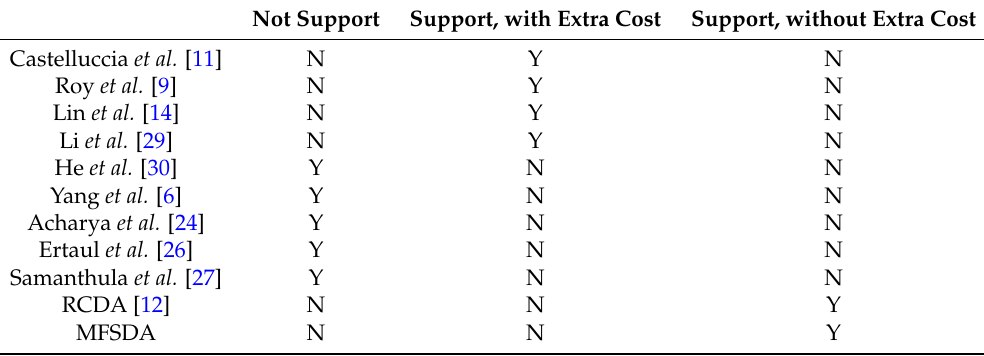
Table 2. Comparison of SDA schemes on adaptive dynamic